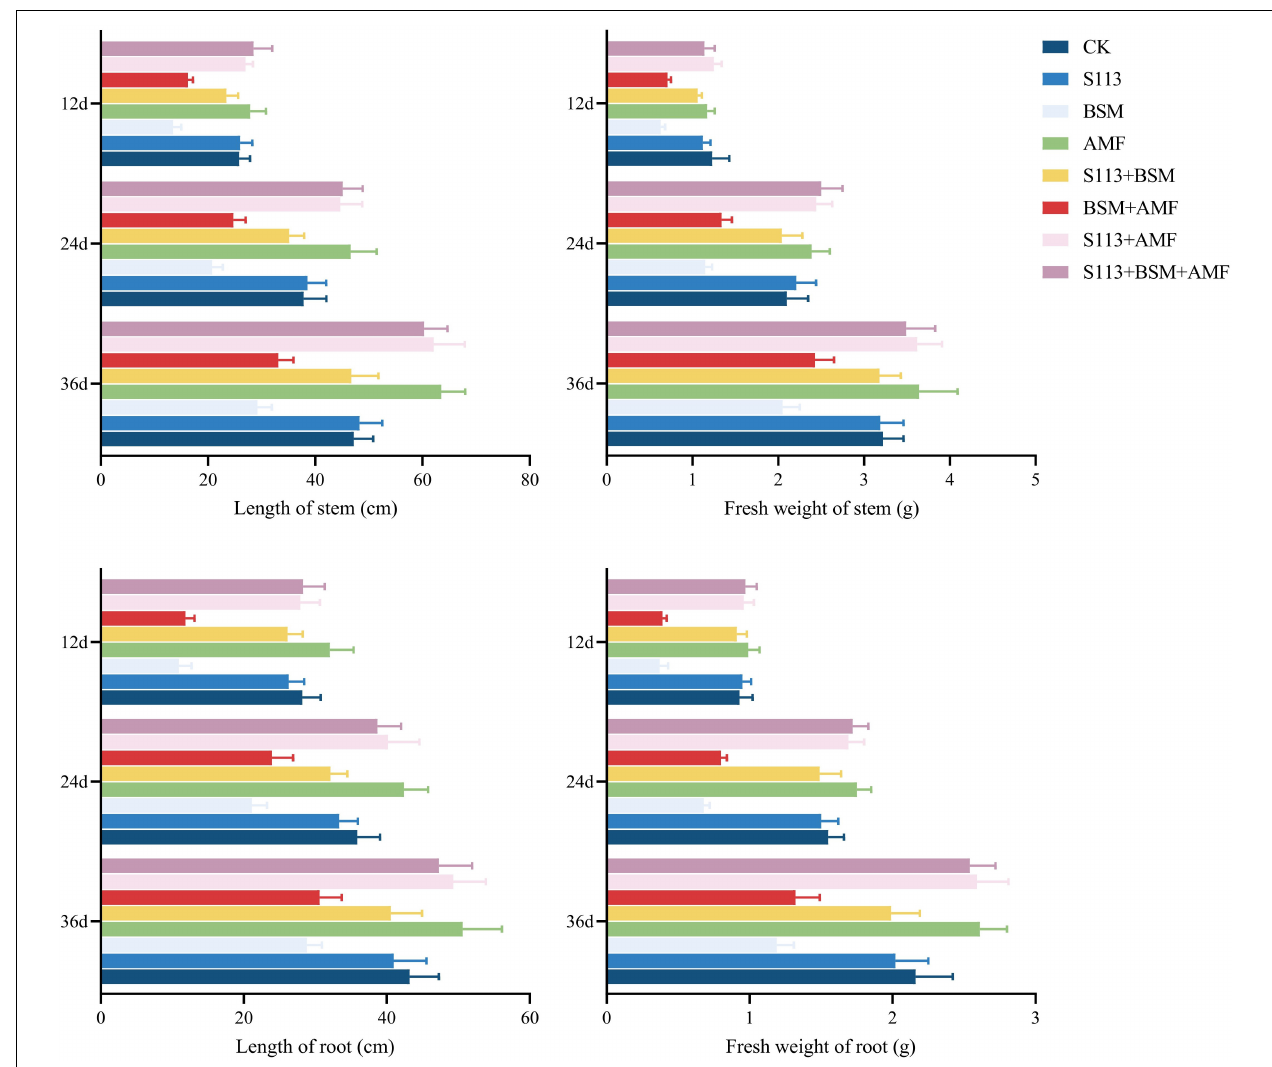
FIGURE 6 | The growth of maize under different treatments. CK: the seedlings without Bensulfuron-methyl (BSM) and S113 or Arbuscular mycorrhizal fungi (AMF); S113: seedlings were inoculated with S113 by root irrigation; BSM: soils were treated with bensulfuron-methyl, 3.0 mg/kg; AMF: seedlings were inoculated with AMF spore suspension (200 µ L); S113 + BSM: seedlings were treated with BSM and inoculated with S113; AMF + BSM: seedlings were treated with BSM and inoculated with AMF spore suspension; S113 + AMF: seedlings were inoculated with S113 and AMF spore suspension; S113 + BSM + AMF: seedlings were inoculated with S113 and AMF spore suspension, and soils were treated with